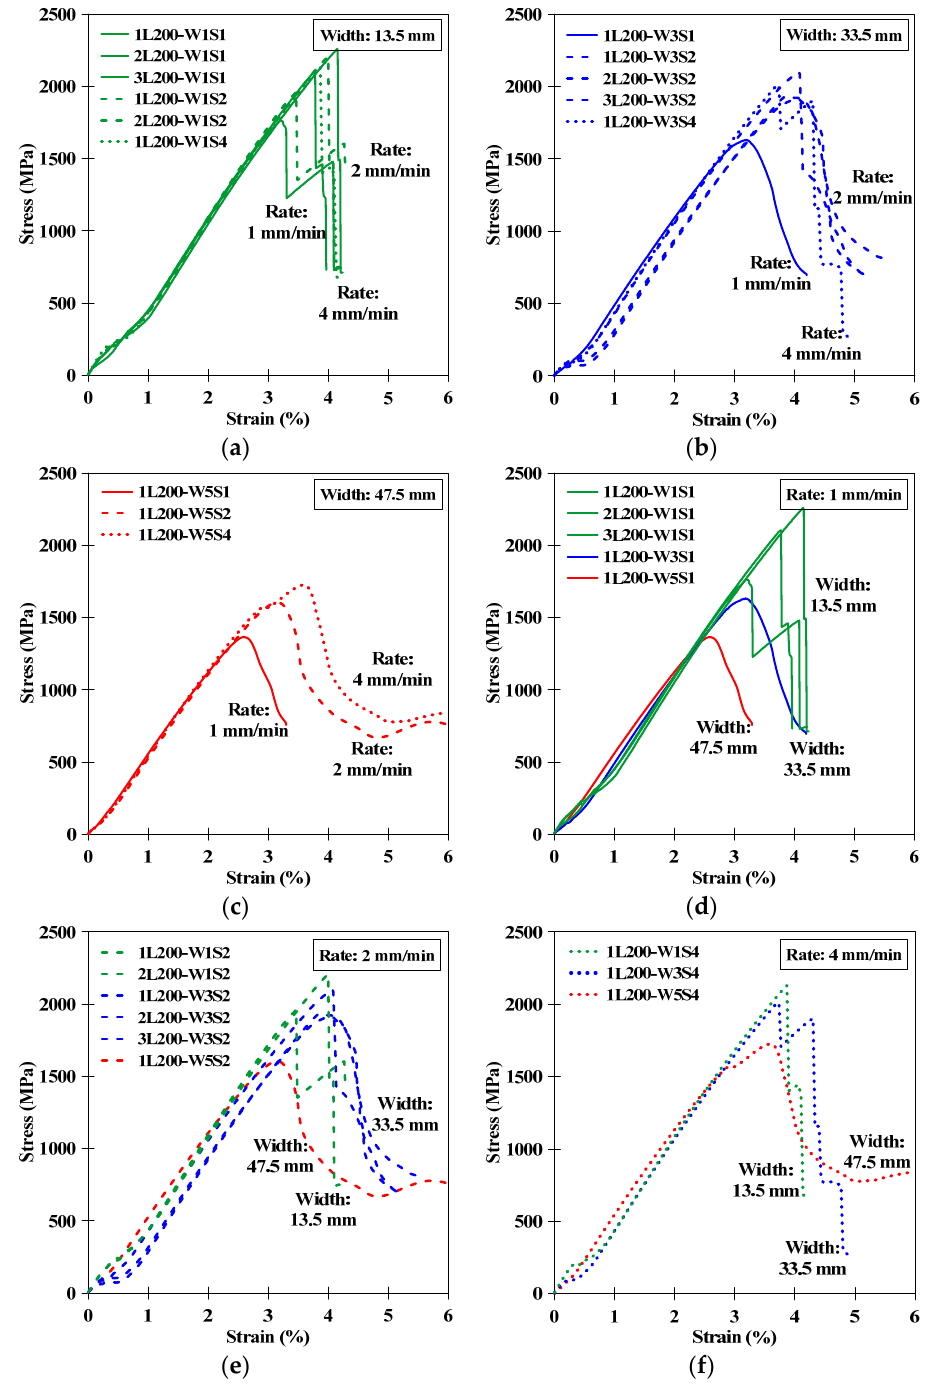
Figure 10. Stress-strain results of 200 mm long specimens, clamped using leather: ( a – c ) set width and variable displacement rate and ( d – f ) set displacement rate and variable